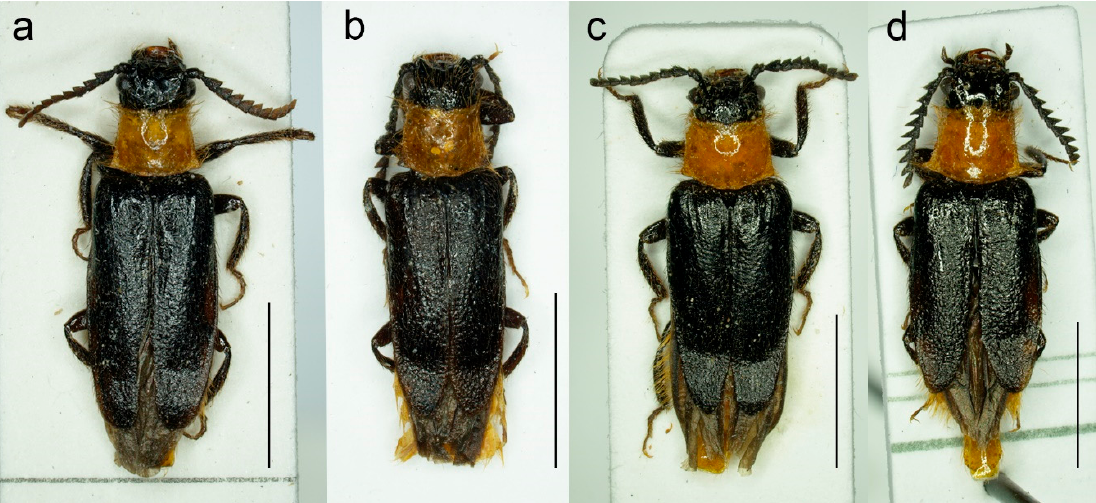
Figure 14. Malacogaster nigripes Schaufuss, 1867, male, habitus, dorsal view. ( a ) Specimen from Mallorca (PCRK); ( b ) Specimen from Mallorca (HNHM); ( c ) Specimen from Mallorca (NKME); ( d ) Specimen from Morocco (NKME). Scale bars = ( a , b , d ) 3.0 mm; ( c ) 3.5 mm.